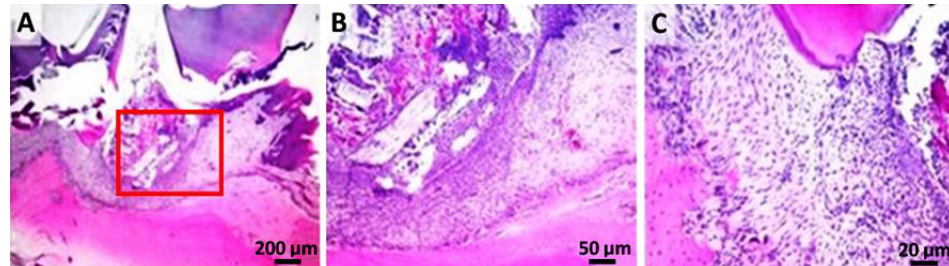
Figure 5. Periodontisis group: ( A , B ) the superficial area of the inflammatory outbreak covered by tissue and fodder debris; ( C ) detail of the dental support device, with moderate-segmental osteo- clastic resorption of the alveolar bone and suppurated periodontitis; (hematoxylin – eosin). In the L group (Figure 6), an important hyperplasia and hyperkeratosis (orthokeratotic) of the gingival epithelium with the formation of irregular, anatomic epithelial papillae, sepa- rated by a fibro-vascular inflammatory stroma (primarily neutrophils), moderate-segmental osteoclastic resorption of the alveolar bone, and suppurated periodontitis was observed. The inflammatory process was represented by bands and degenerated neutrophils in mixture with rarely mononuclear cells and reactive